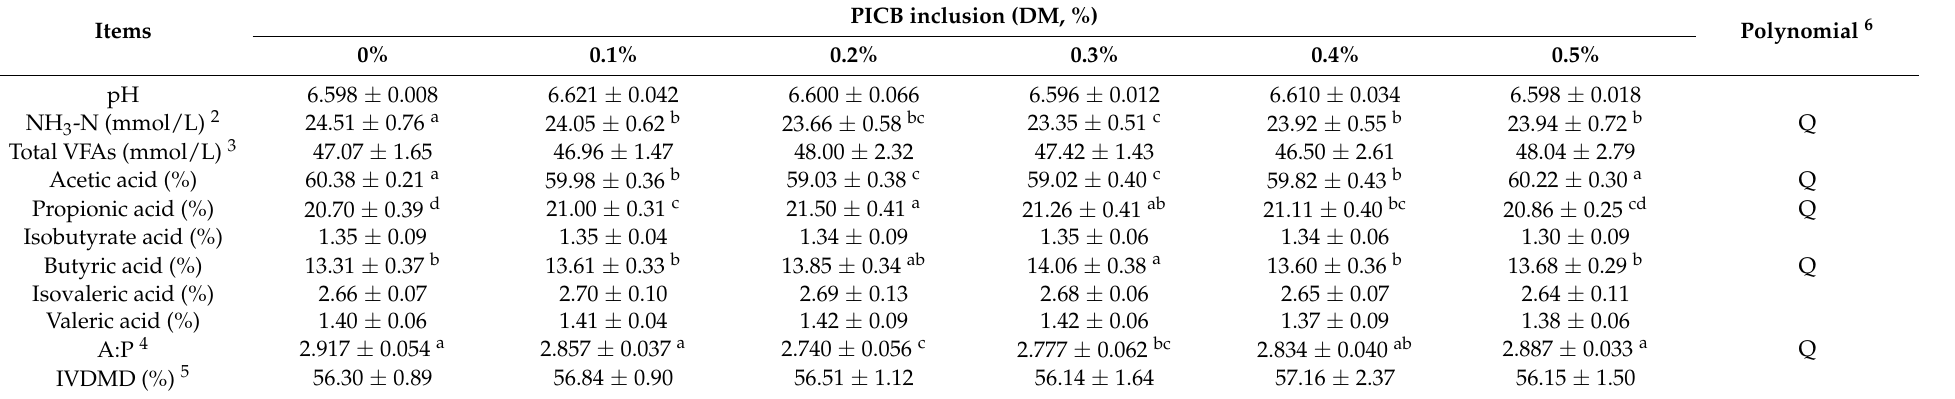
Table 2. pH, NH 3 -N, total VFAs and their components, and DM degradation after 24-h in-vitro fermentation with different doses of PICB 1 .